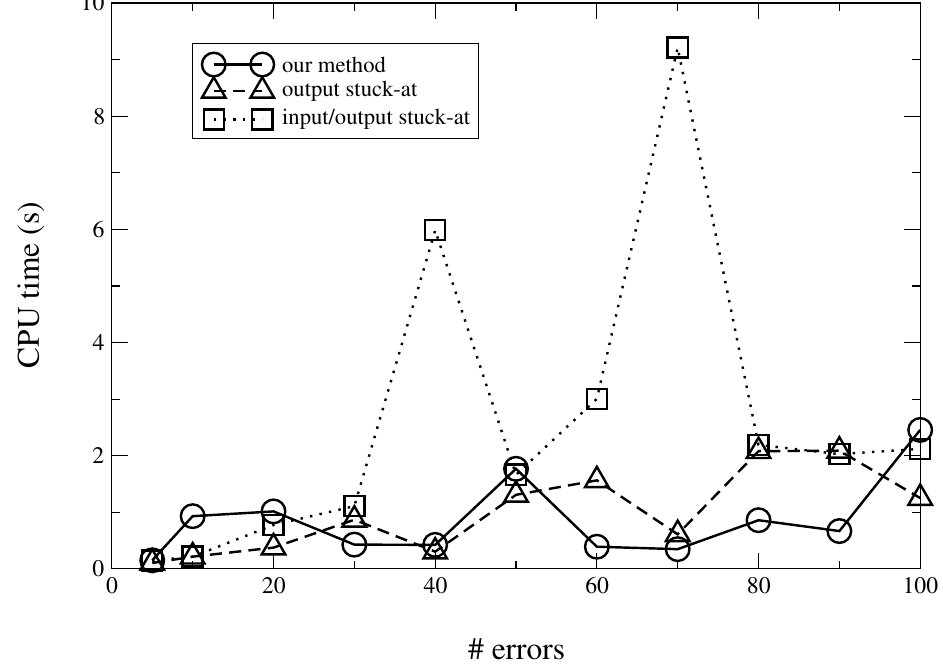
Figure 8. CPU time used by a SAT solver for processing the Boolean model of a five-input LUT implementation of b14 in the presence of multiple faults, for output stuck-ats, input/output stuck-ats and our